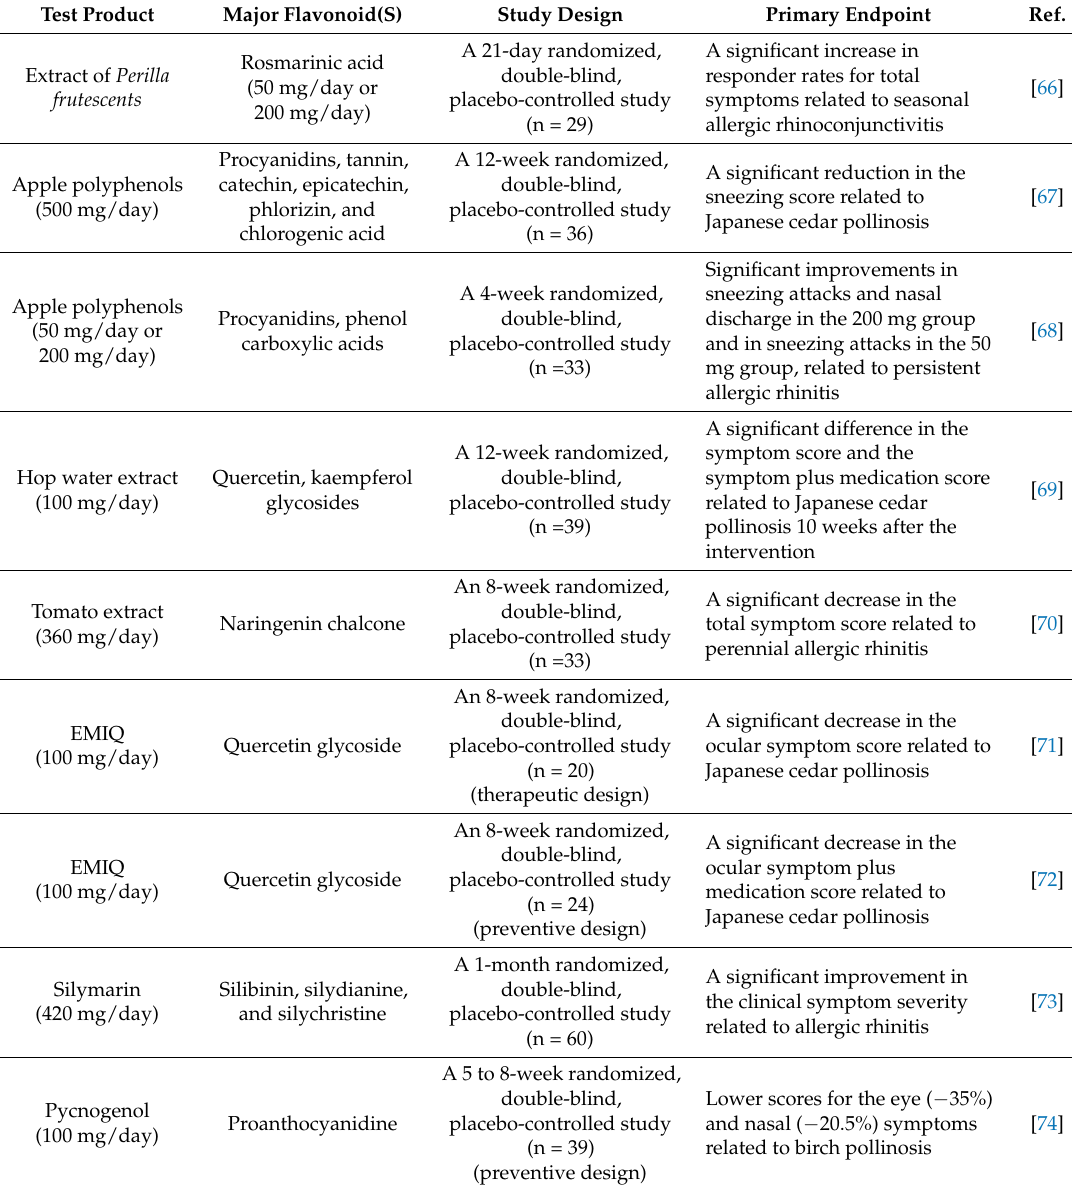
Table 2. Clinical studies of flavonoids in allergic